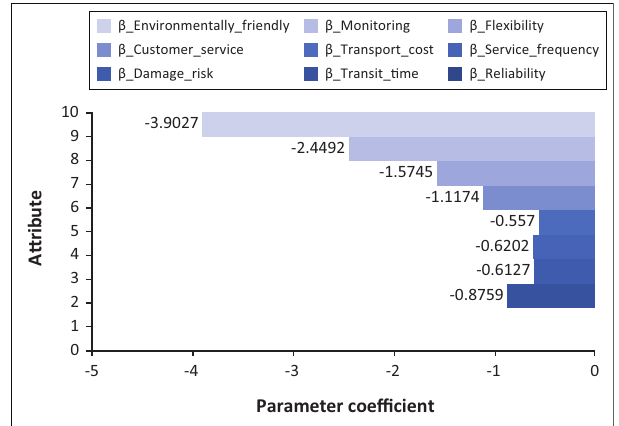
FIGURE 6: Graphical presentation of attribute